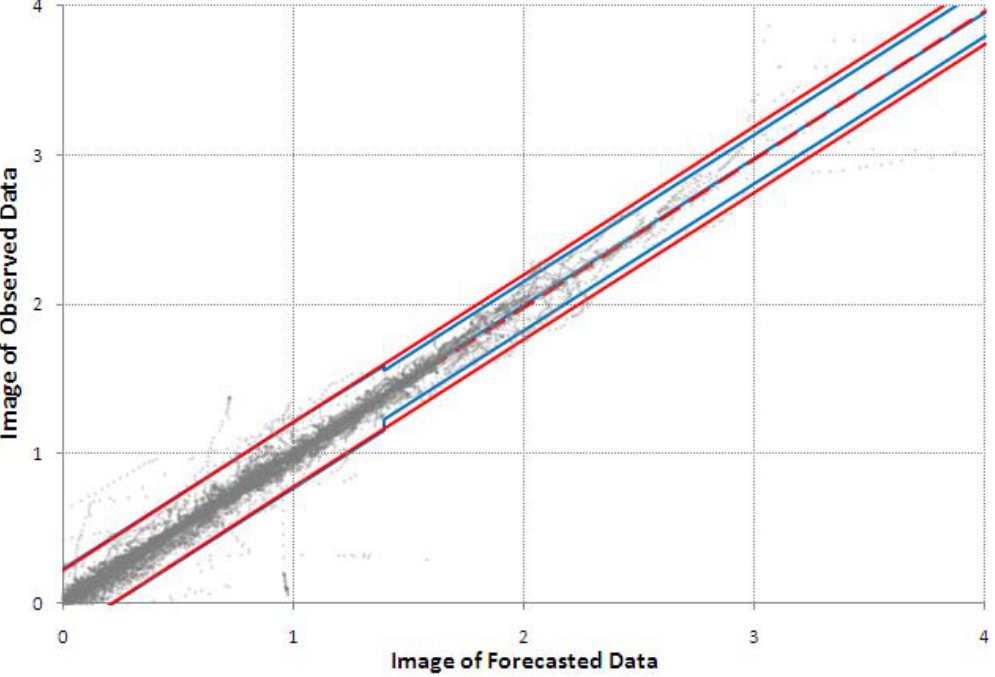
Fig. 8. Zoom of the high values shown in Fig. 7. The full red lines represent the 5% and 95% quantiles and the dashed red line the 50% quantile obtained without using the TNDs methodology. The blue lines represent the quantiles obtained using the TNDs methodology.